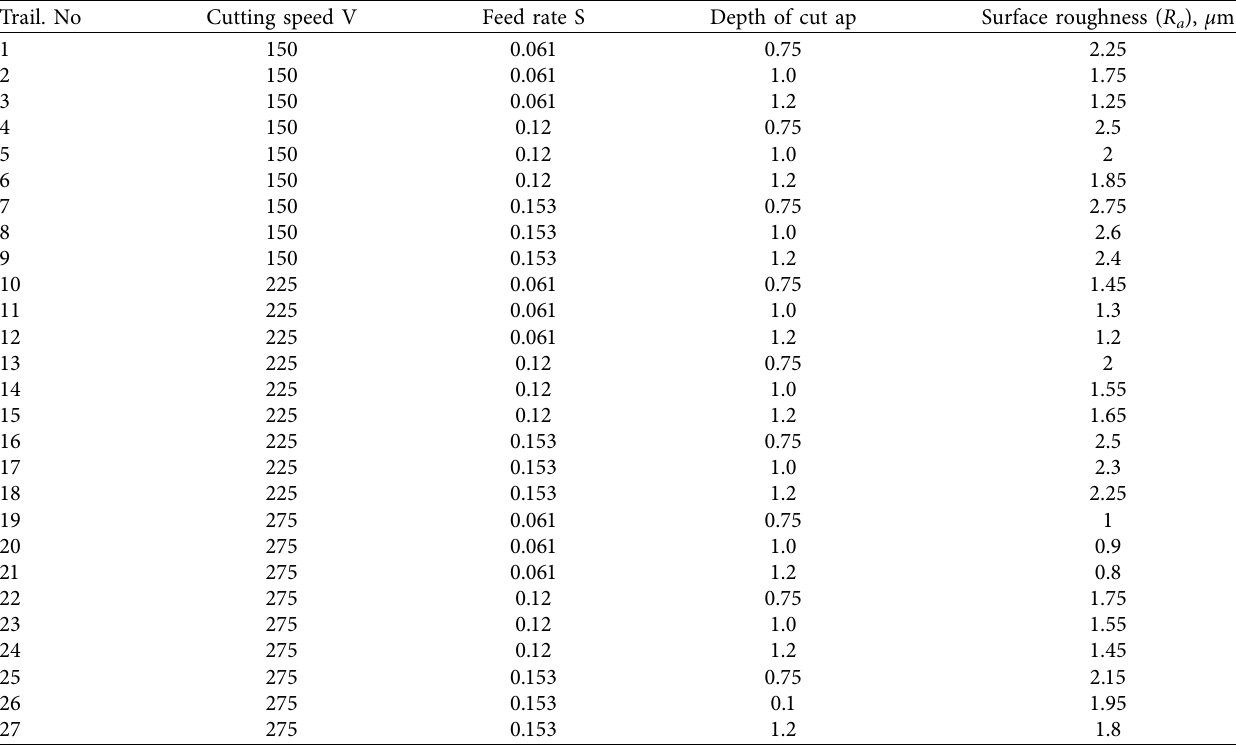
Table 2: Experimental trial results.